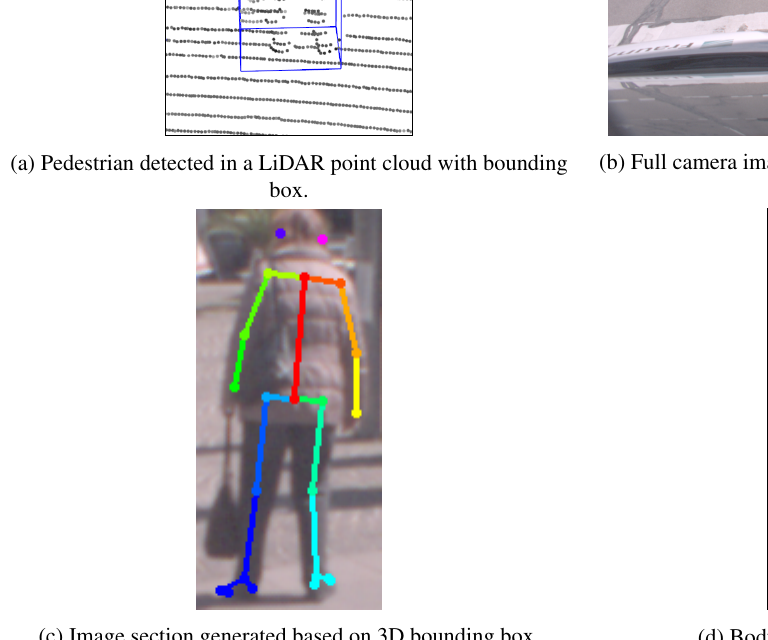
(d) Body pose projected into 3D space.